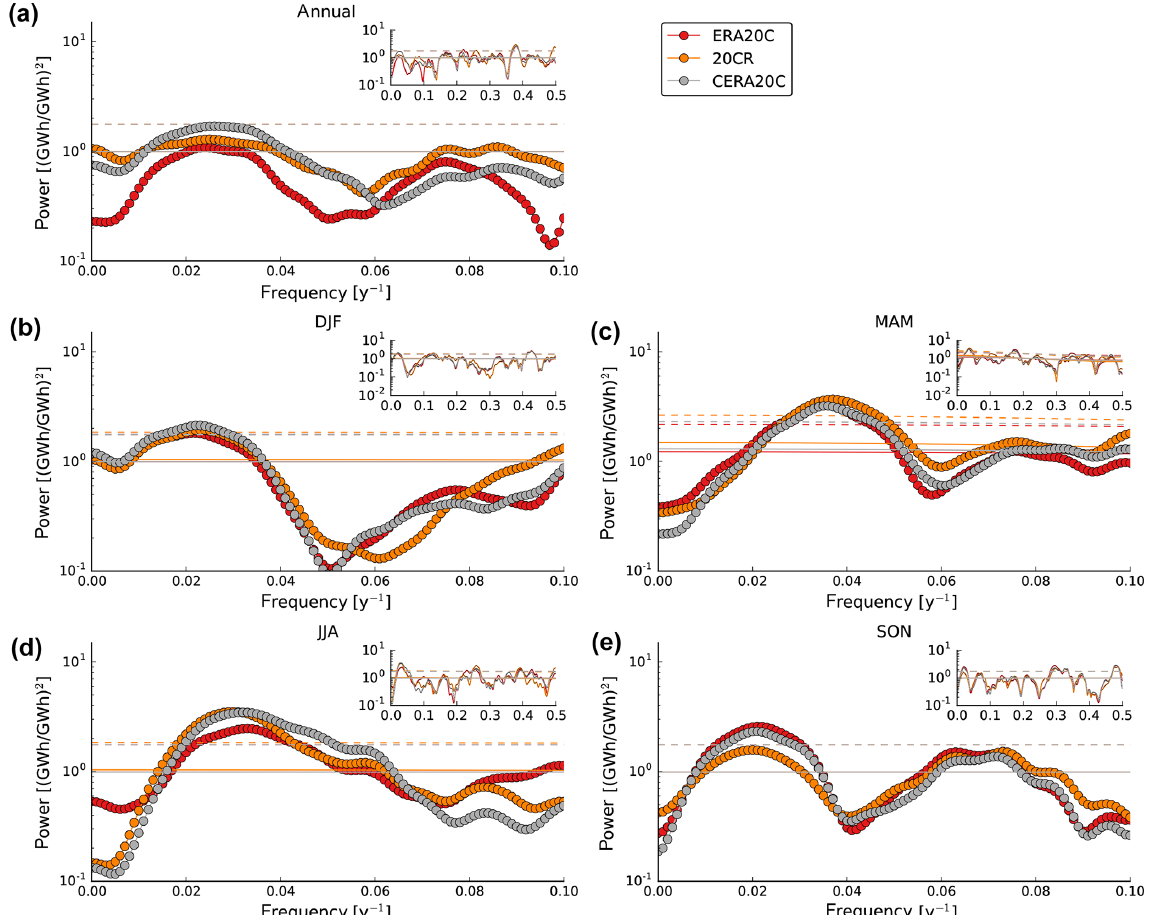
Figure 5. Spectral analysis of the wind generation time series using the multitaper method (MTM). Panels report annual (a) and seasonal spectra (b–e) . Focus is given to the low-frequency component with frequencies of less than 0.1 yr − 1 while the full spectrum is shown in the inset of each panel. Solid lines represent the fitted spectrum of an AR(1) process that is used for significance testing and the dashed lines correspond to the 90% confidence level for each dataset (see Sect. 2 for